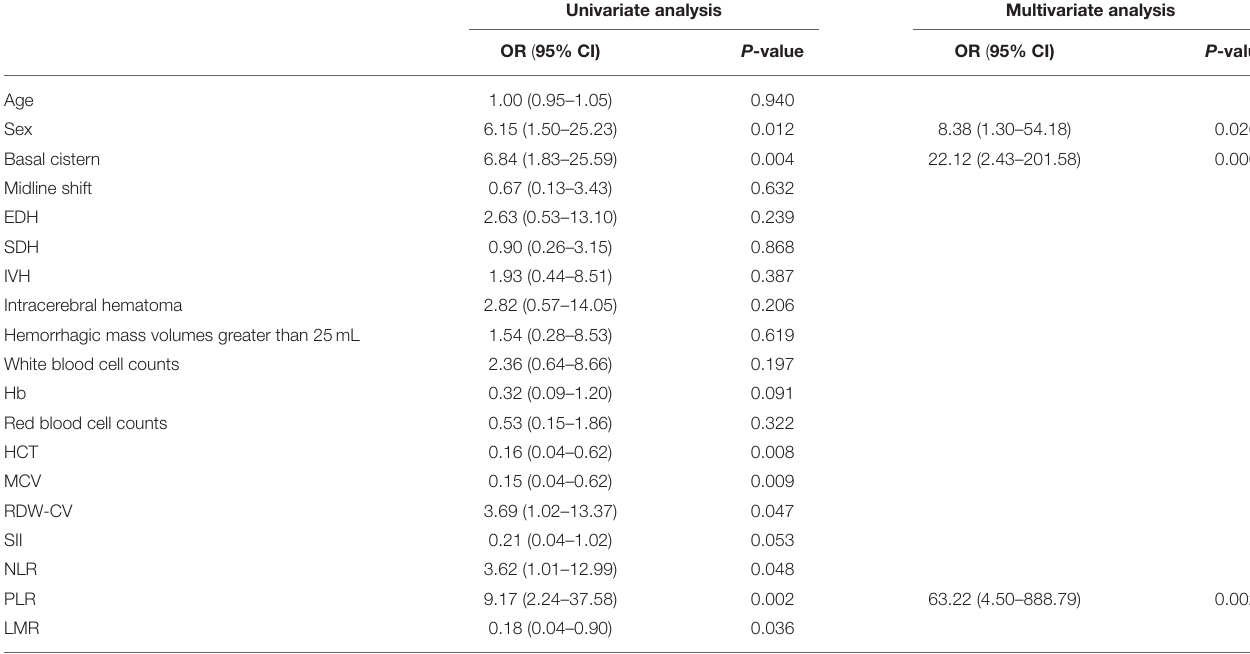
TABLE 3 | Univariate and multivariate analysis of early pediatric mortality in the training cohort. Univariate analysis Multivariate analysis